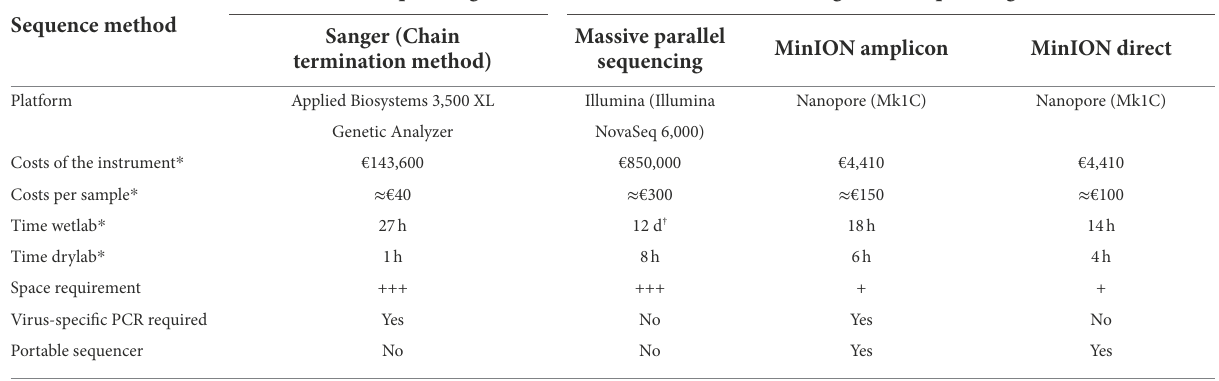
TABLE 4 Comparison of the most important genome sequencing variables in Sanger (partial genome sequencing), and Illumina, MinION amplicon, and MinION direct (whole-genome sequencing).